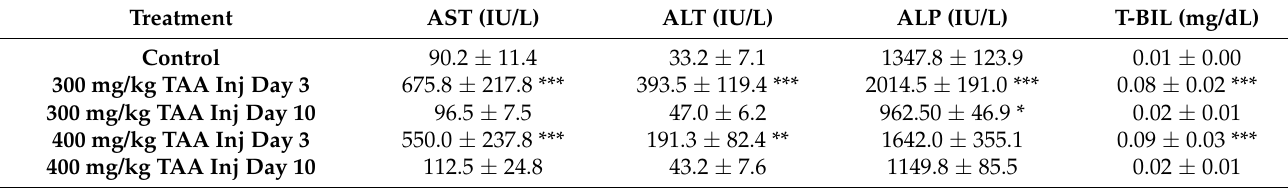
Table 1. Serum AST, ALT, ALP, and T-BIL levels of TAA-treated rats. Treatment AST (IU/L) ALT (IU/L) ALP (IU/L) T-BIL (mg/dL) Control 90.2 ±